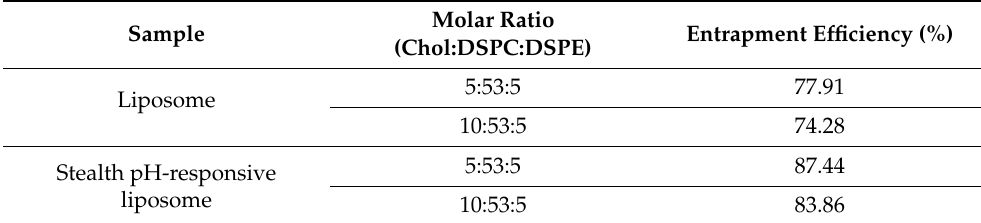
Table 3. Percentage of curcumin entrapment efficiency.